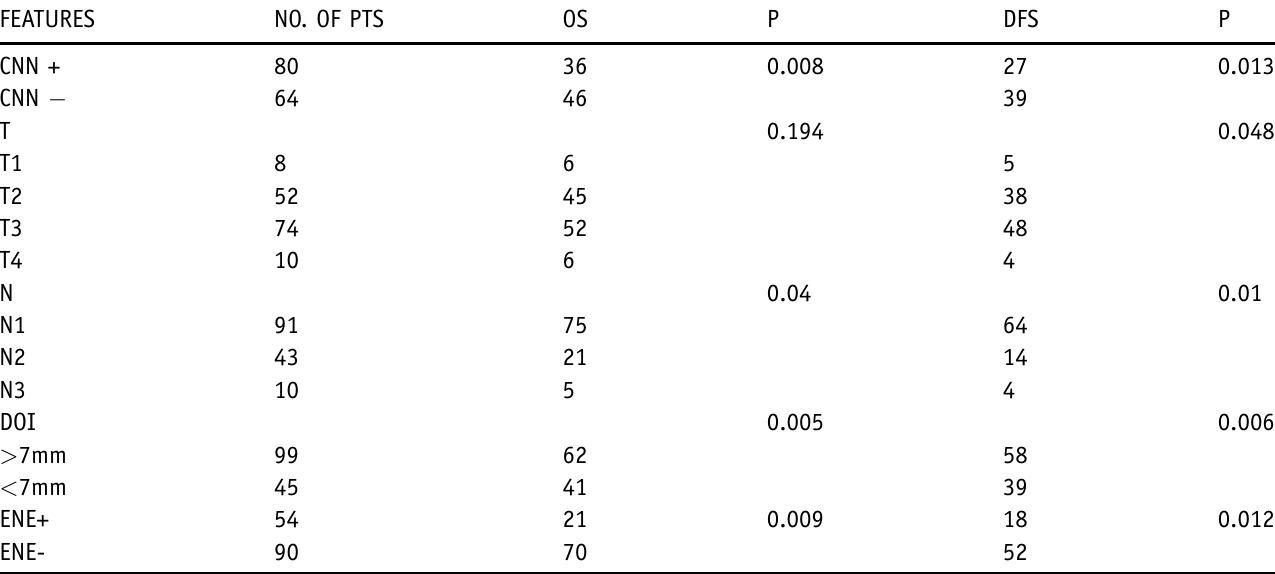
Table II. Univariate Analysis of Variables Associated With Survival Outcomes of Patients With Tongue Squamous Cell Carcinoma With Cervical Nodal Necrosis (CNN) (CNN Group) or Without CNN (Non-CNN Group) on Preoperative MRI.